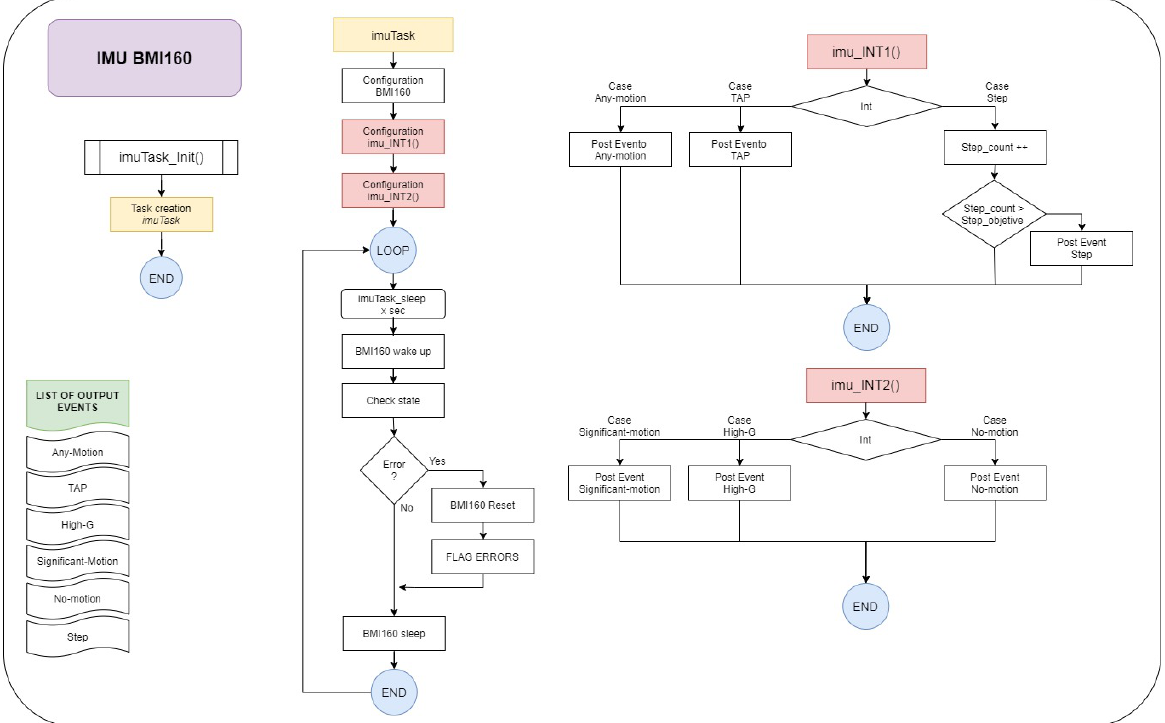
Figure 3. Electronic modules